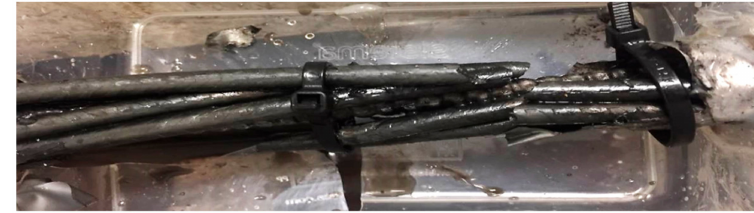
Figure 12. Failed TG bolts with indented